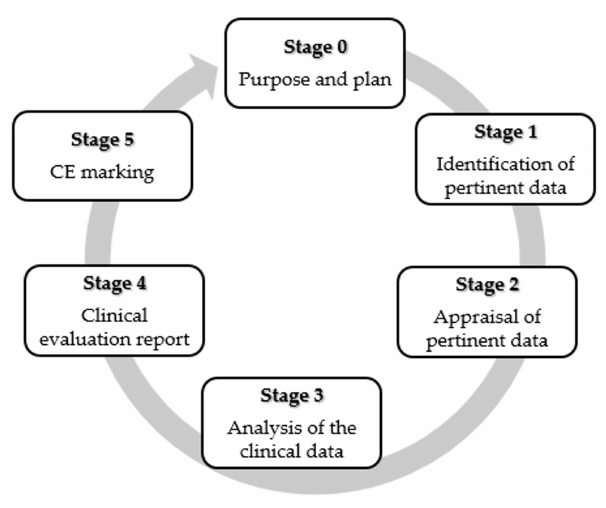
Figure 6. Di ff erent stages of the clinical evaluation. Modified from [195]. CC BY